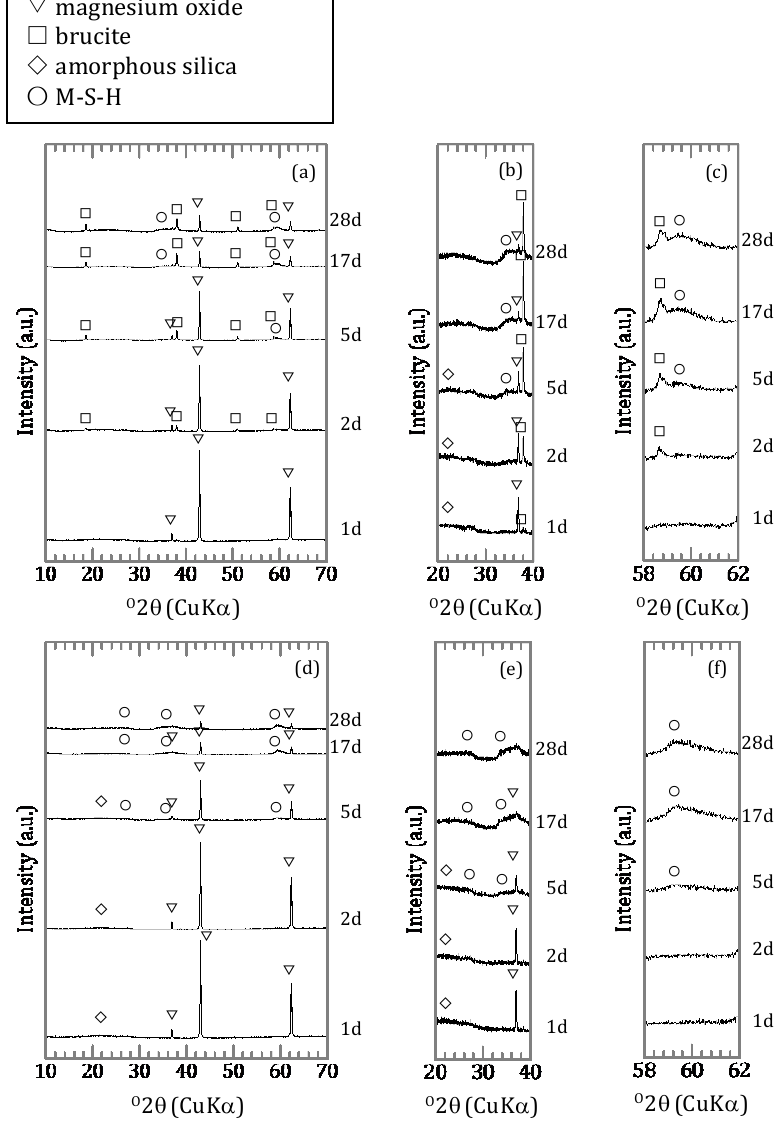
Figure 5. XRD spectra of samples with amorphous silica; ( a ) [B] ini = 0.46 mmol/L and ( d ) [B] ini = 9.25 mmol/L with magnified spectra of ( a ) and ( d ) for ( b and e ) 35–40° and ( c and f ) 45–65° in 2 θ .